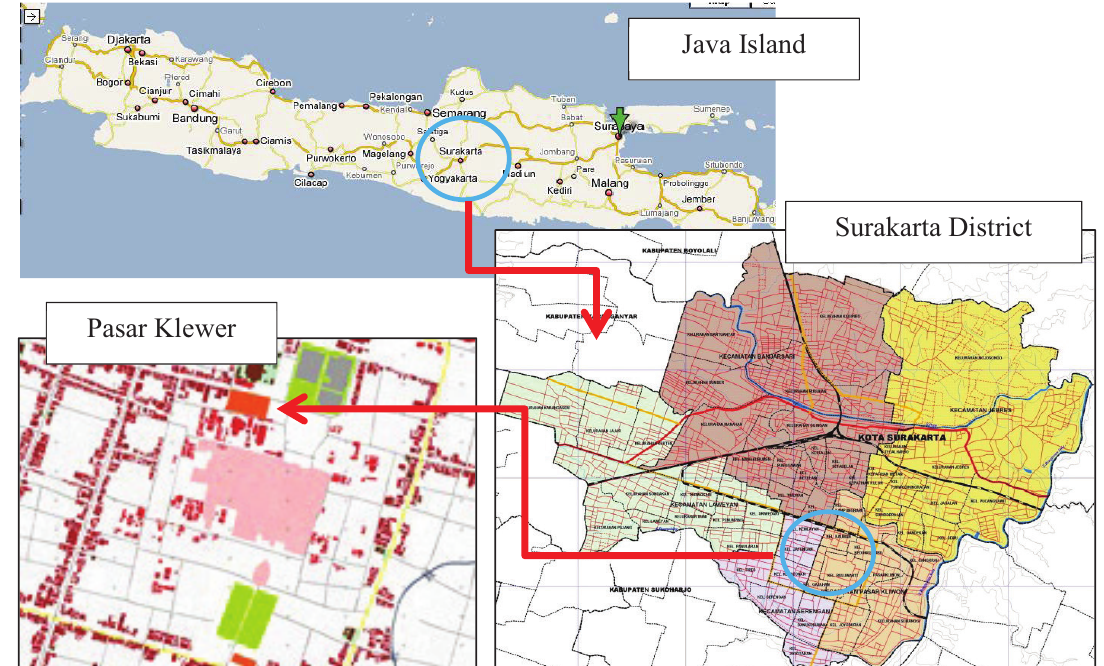
Figure 1. Position of research location, Surakarta district and Pasar Klewer in Javanese Island constellation,